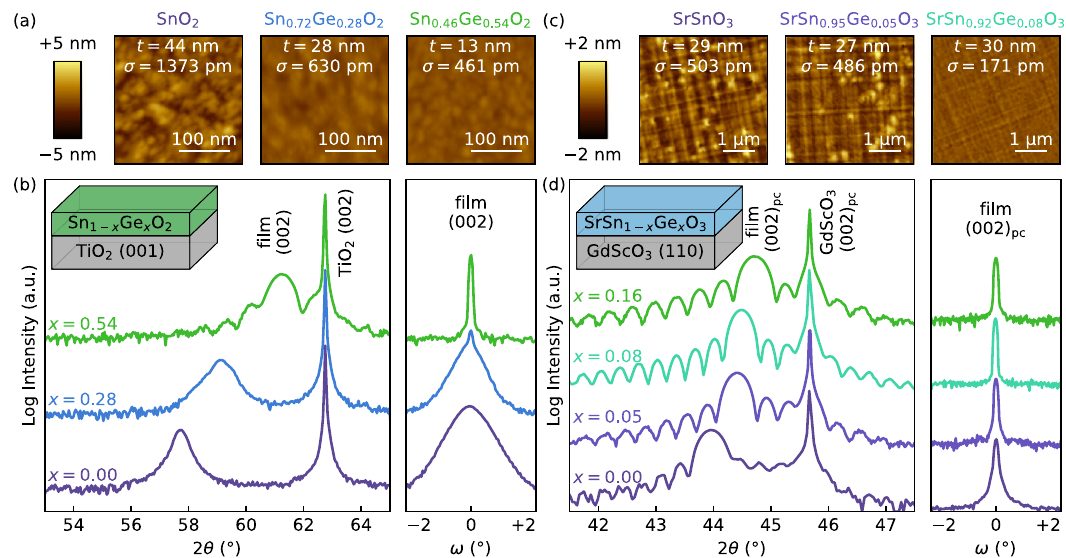
Fig. 3 Surface morphology and structural quality of Ge-based oxides. a Atomic force microscopy (AFM) of Sn 1- x Ge x O 2 /TiO 2 (001) fi lms showing smooth fi lm surfaces. b Room-temperature high-resolution X-ray diffraction (HRXRD) 2 θ - ω coupled scans and rocking curves around the (002) fi lm peak of Ge x Sn TiO 2 (001) fi lms. c AFM images of SrGe x Sn 1- x O 3 /GdScO 3 (110) showing fi lm surfaces that get smoother with Ge incorporation. d Room-temperature HRXRD 2 θ - ω coupled scans and rocking curves around the (002) pc fi lm peak of SrGe x Sn 1- x O 3 /GdScO 3 (110). The insets of ( b , d ) show the fi lm structures.